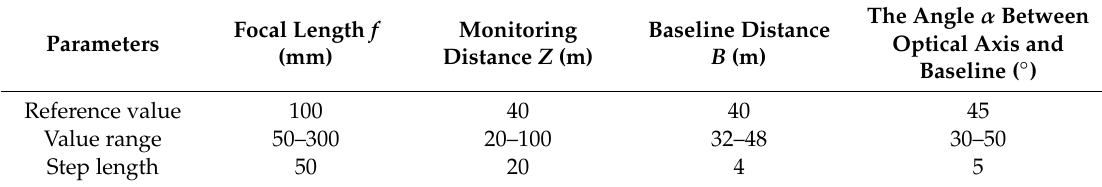
Table 2. In engineering applications, appropriate cameras and structure parameters combination can be selected according to specific precision requirements, monitoring scene and project